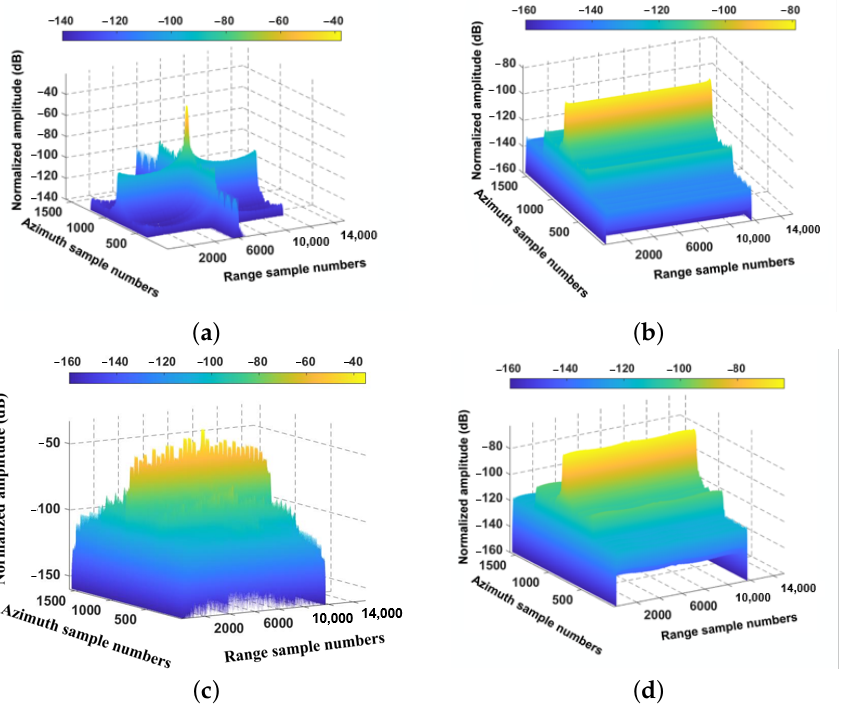
Figure 6. Focusing results (HV polarization channel of a conventional quad-pol mode) of different transmission scheme (dB) in correspondence of the first near range ambiguity portion for: ( a ) up chirp waveform, ( b ) up-down chirp waveforms, ( c ) OFDM chirp waveforms, and ( d ) quasi-orthogonal NLFM